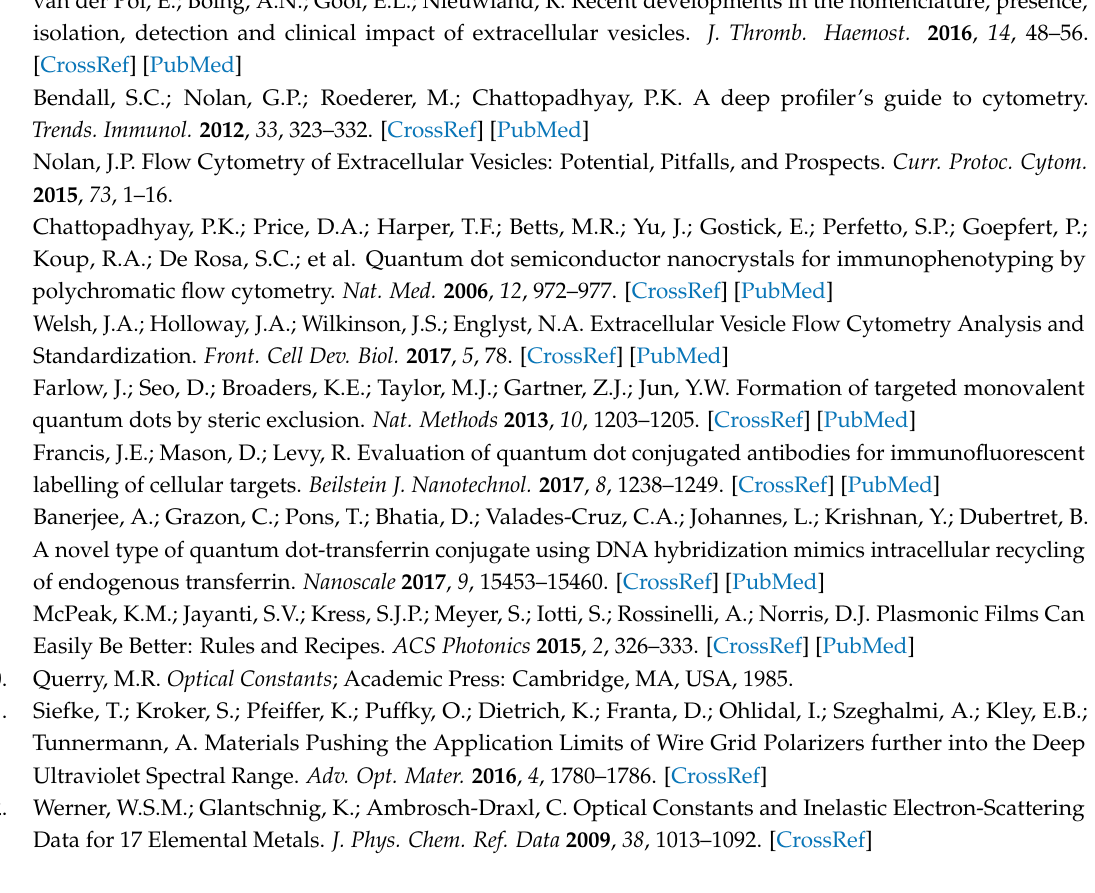
Figure S1: Refractive index (A) and extinction coefficient (B) of zirconium, titanium dioxide, platinum, lead, iron oxide, copper, cadmium selenide, gold, and silver at wavelengths between 300–800 nm.; Figure S2: Serial dilutions of 40 nm (A,B), 60 nm (C,D), and 80 nm (E,F) Au nanoparticles.; Figure S3: Modelling data of each detection wavelength.; Figure S4: Modelled scattering cross-sections assuming Astrios EQ collection optics.; Figure S5: Comparison of the scattered optical power at 488 nm wavelength for gold, silver, and polystyrene nanoparticles measured on Astrios EQ and FACS Symphony flow cytometers in the forward (FSC) and sideward (SSC) direction. Figure S6: Multi-wavelength particle scattering models of the Astrios EQ vs. acquired multi-wavelength particle scattering data on the Astrios